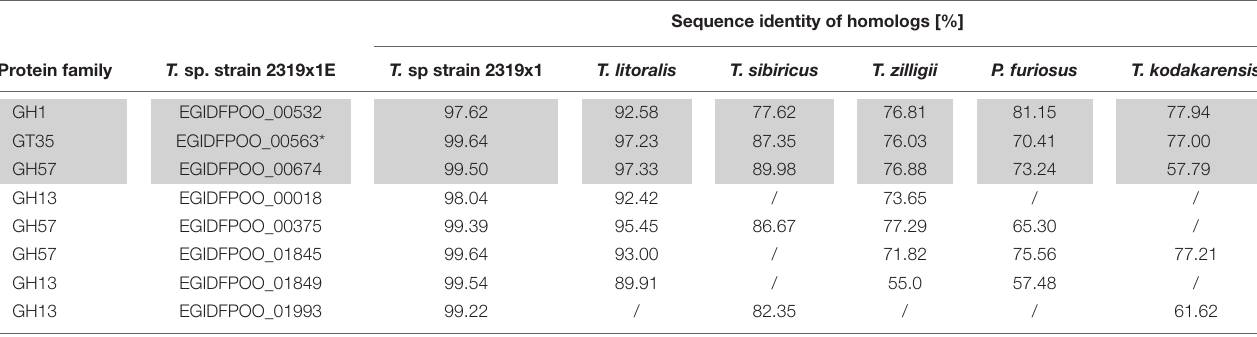
TABLE 3 | Distribution of glycosyl hydrolase homologs (according to BLASTP) of upregulated proteins identified by ABPP or comparative proteomics during growth on xylan in Thermococcus sp. strain 2319x1E in other members of the Thermococcales